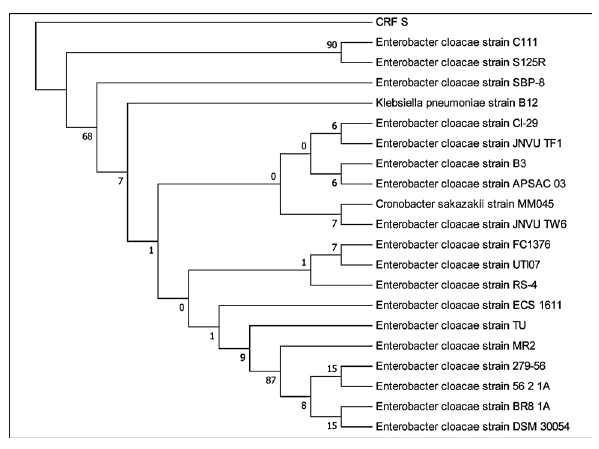
Fig. 6. Phylogenetic tree of CRF(S)